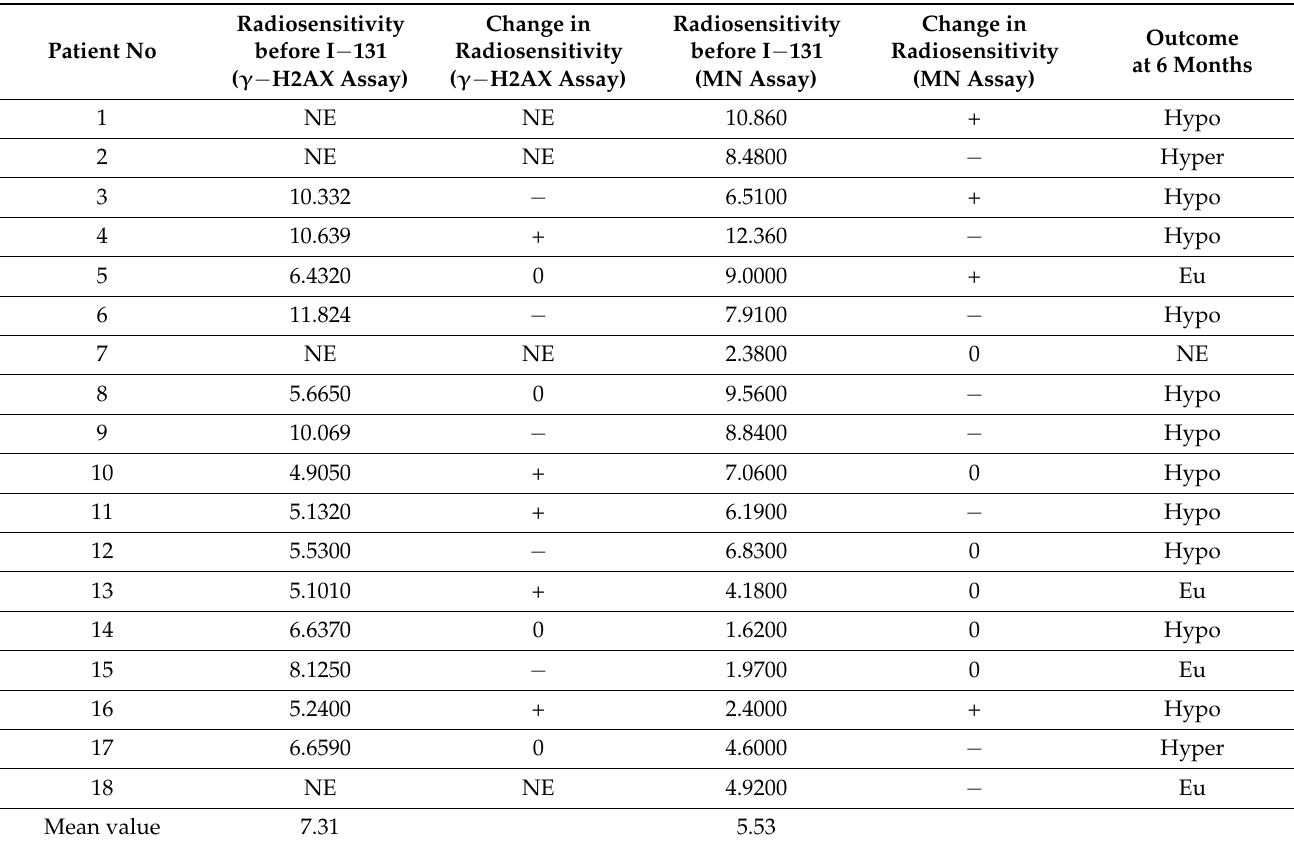
Table 2. Values of radio-sensitivity before the treatment and type of radio-sensitivity changes after the treatment together with the clinical